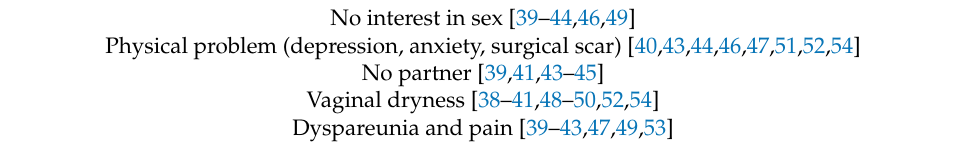
Table 2. The main reported reasons for sexual